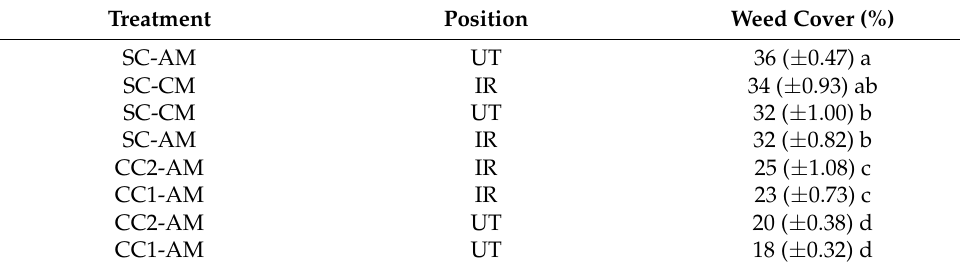
Table 3. Effect of the interaction between treatments (CC1-AM, CC2-AM, SC-AM, SC-CM) and positions (IR and UT) on weed cover percentage.